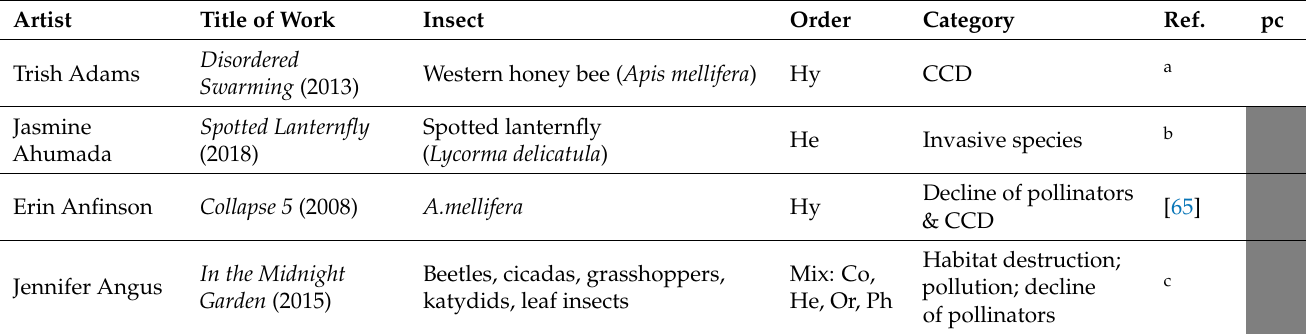
Table A1. Artists using insects to convey a message concerning human-induced